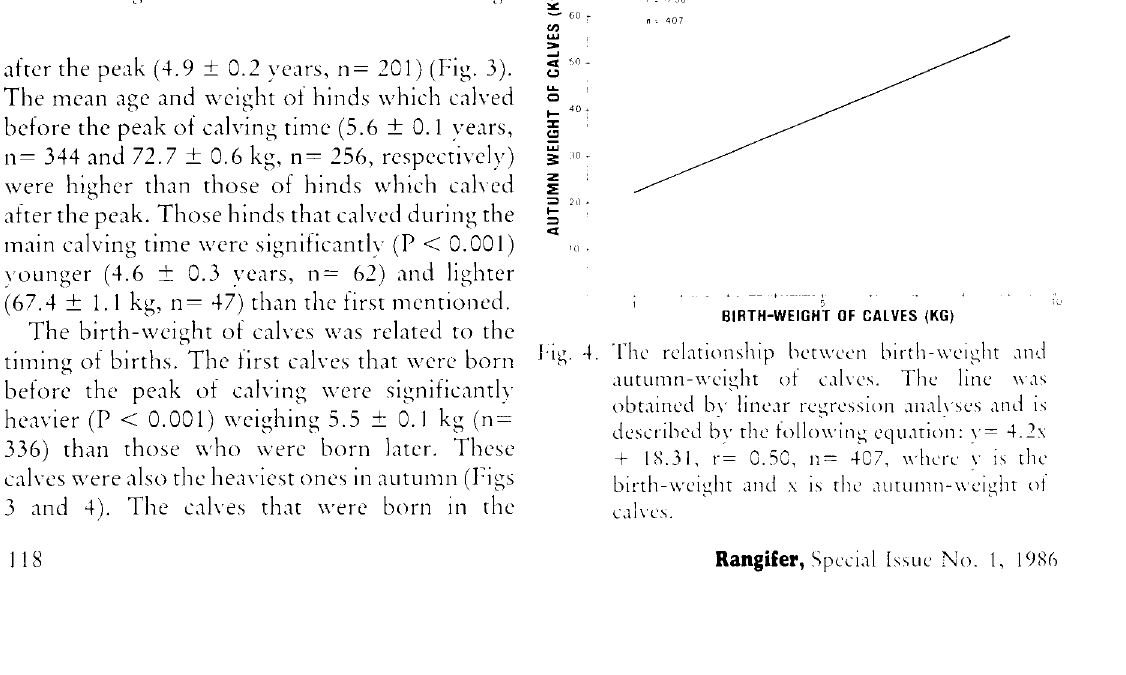
Fig. 3. Birth-weight, autumn-weight and age (x ± S.E.) of calved females in relation to timing of births. Peak calving (50% calves born) was 22 May and mean calving (90% calves born) 29 May. The lines are described according to groups; calves born before peak calving, during peak calving, after peak calving but before the main calving, during the mam calving and calves born after the main calving.